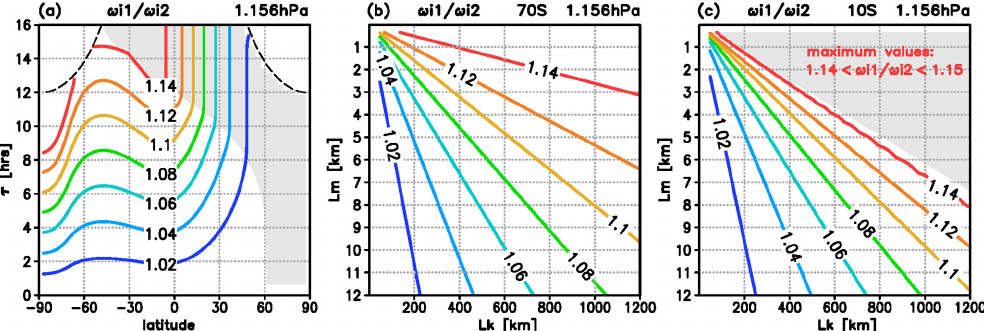
Figure 3. Amplification factor ω i 1 /ω i 2 at a level of the maximum values of ω i 1 /ω i 2 (1.156hPa) illustrating the decrease in the intrinsic frequency with ( ω i 2 ) compared to without ( ω i 1 ) ozone–temperature coupling (compare with Fig. 1e–f), (a) latitudinal distribution of ω i 1 /ω i 2 as a function of the initial wave period τ i [in h], and (b–c) dependence of ω i 1 /ω i 2 on the horizontal and vertical wavelengths L k and L m [in km] at (b) 70 ◦ S and (c) 10 ◦ S. Shaded areas show where the amplification is limited by the length of daytime ( τ i > τ day